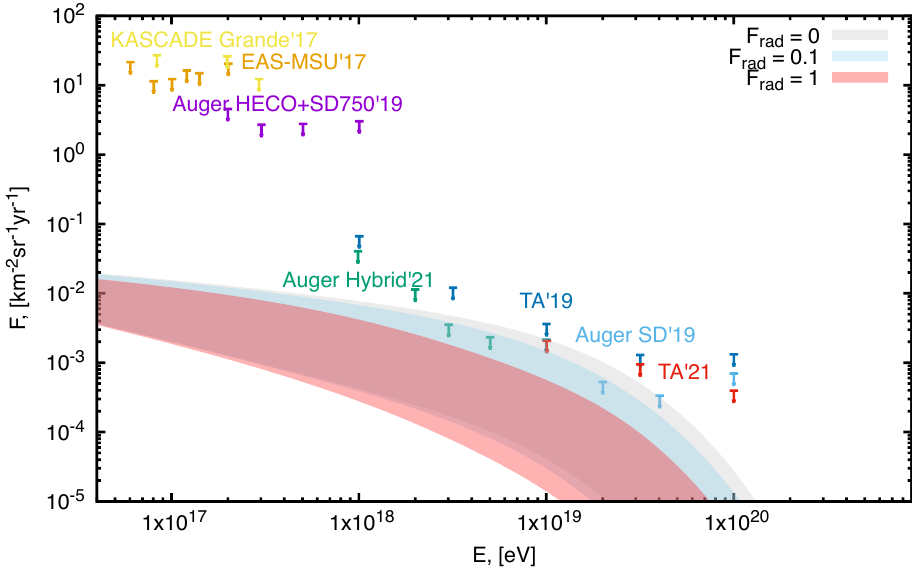
Figure 3. Bands of predicted UHECR photon fluxes assuming only proton primaries (whose maxi- mum is at the level of the TA UHECR spectrum [37]) for source parameters 0 < α < 2.8, and E max = 10 20 eV and the injection spectrum in Equation (1). The bands in pink, sky blue, and gray assume respectively the lower radio background model of Protheroe and Biermann [44] multiplied by the factors F rad = 1, F rad = 0.1 and F rad = 0. Also shown are past and present experimental upper limits by Auger [26,27], TA [45,46], KASCADE Grande [47], and EAS-MSU